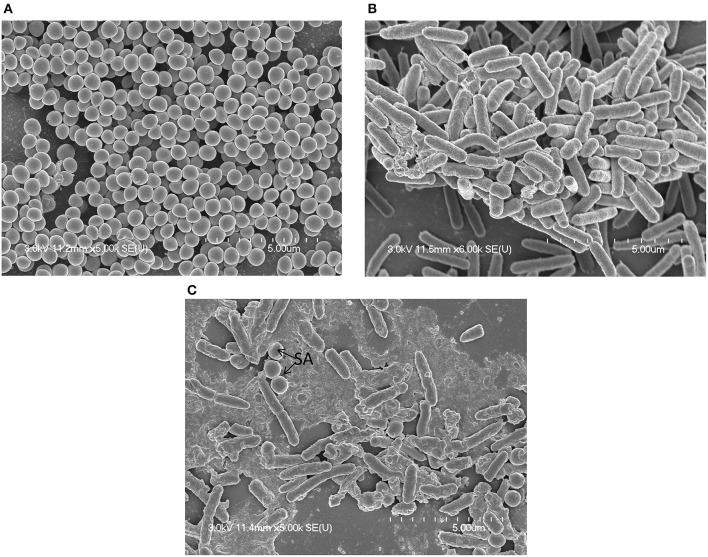
Scanning electron microscope (SEM) images of in vitro biofilms of single or multi-species methicillin-resistant Staphylococcus aureus (MRSA) and Pseudomonas aeruginosa (PA). (A) Representative SEM image of MRSA single species biofilms. (B) Representative SEM images of PA single species biofilms. (C) Representative SEM images of multi-species biofilms of MRSA and PA.